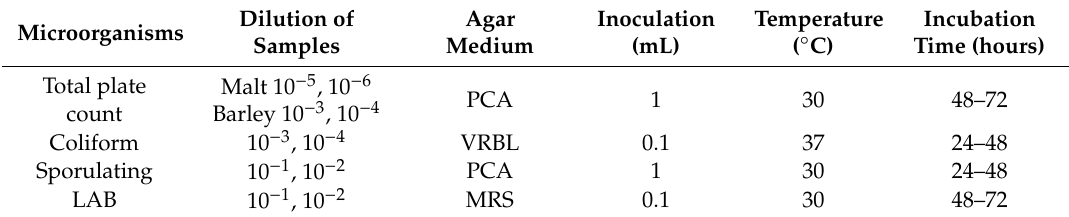
Table 1. Characteristics of the methods